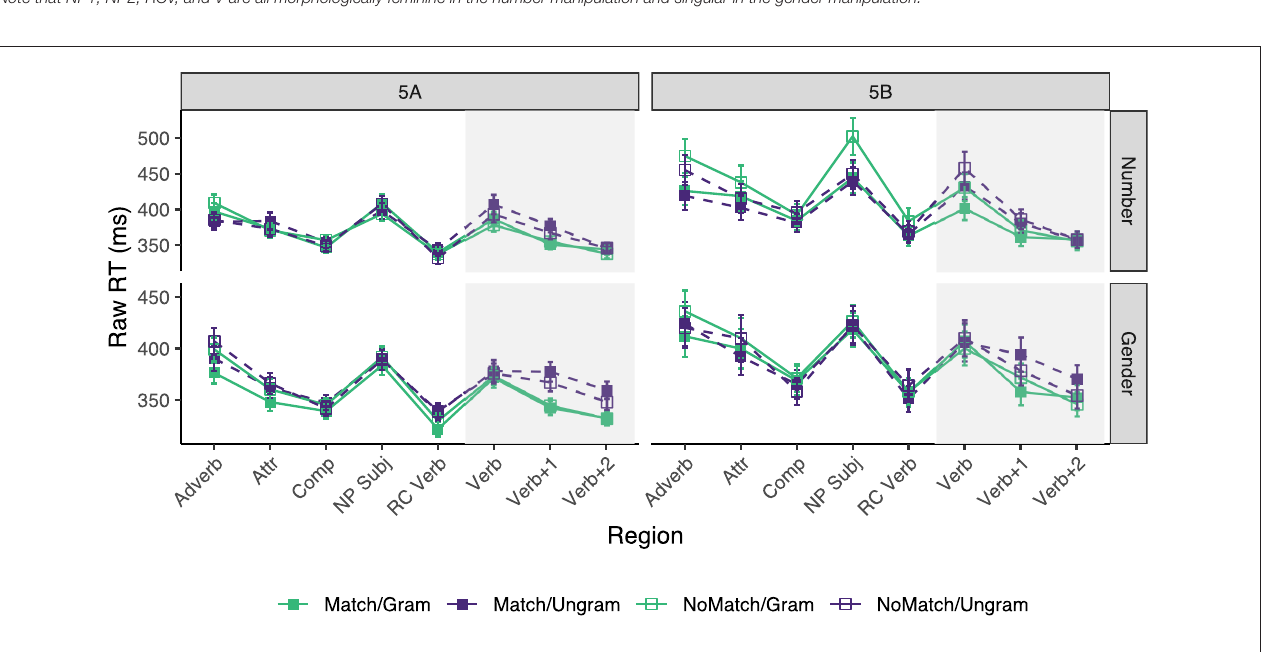
Figure 5 | Mean raw reading times from Experiment 4 for all conditions and regions by subject number. Error bars represent the standard error of the condition mean across participant